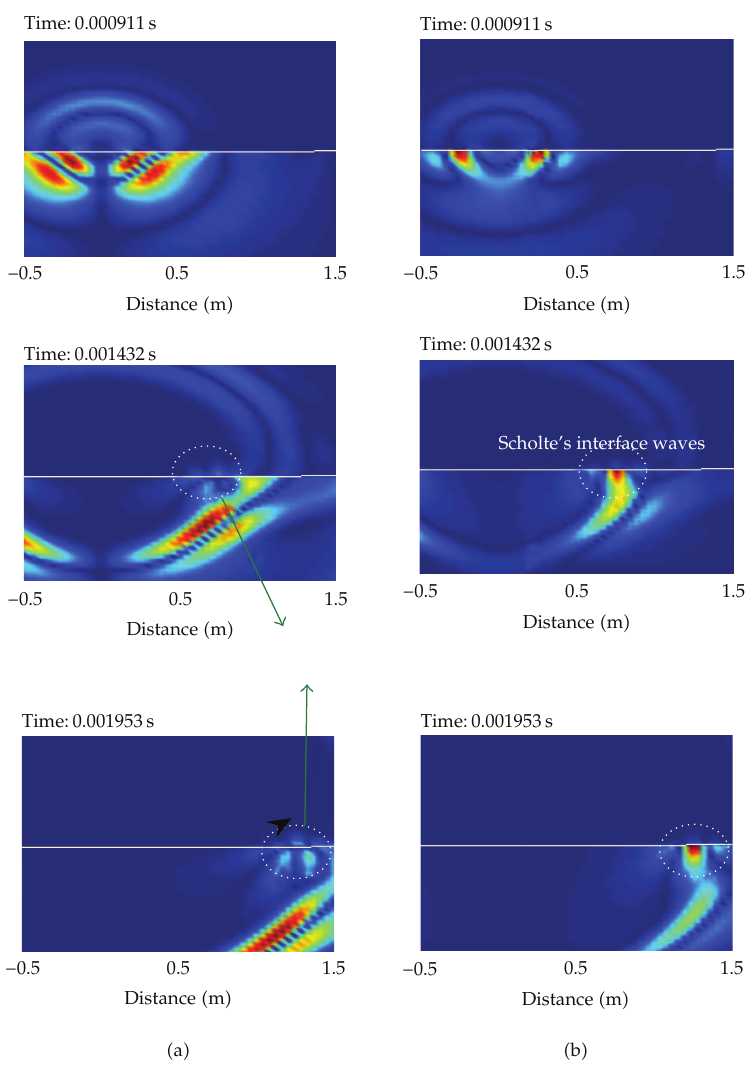
Figure 6: Snapshots by IBEM for the complete 2D water-sandstone interface model are shown. A grid of 51 × 51 receivers, spaced using a distance increment of 0.04m, is required. Column (cid:2) a (cid:5) plots the results of pressures in the fluid and displacements in the x 1 direction for the solid, while the column (cid:2) b (cid:5) plots pressu- res in the fluid and displacements in the x 3 direction for the